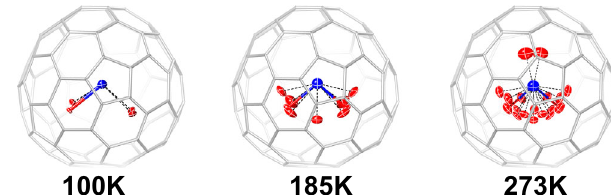
Fig.3|MolecularstructureofUN@ C s (6)-C 82 measuredwithsingle-crystalX-ray diffraction at variable temperatures from 100K to 273K. The displacement parametersareshownatthe 20%probabilitylevelfortheencapsulatedUNcluster. The structures are drawn from the chosen speci fi c direction of the crystal to comparethe dynamics ofthe UN@ C s (6)-C 82 . Color code: blue for N, and red for U.